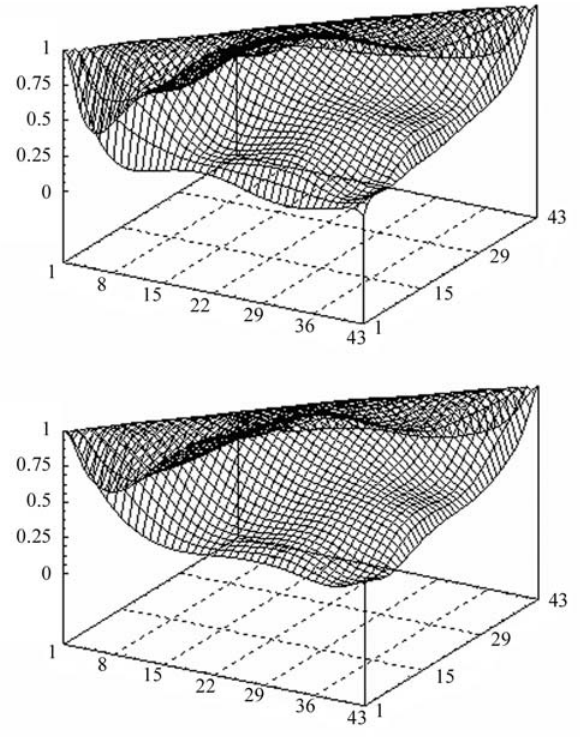
Table 3 - Estimates of variances (diagonal, boldface type), covariances (lower diagonal) and correlations (upper diagonal) between random re- gression coefficients and eigenvalues ( λ ) for additive genetic effects and permanent environmental effects based on the coefficient matrices for two models, one with an order of fit of 6,6,vf6 (k a = 6, k c = 6) and a variance function for residuals (model 10) and the other with an order of fit of 4,6,vf6 (k a = 4, k c = 6) and a variance function for residuals (model 3). The abbreviations k a and k c are the genetic and permanent environmental covariance matrices between random regression coefficients respectively, while vf is the variance function.